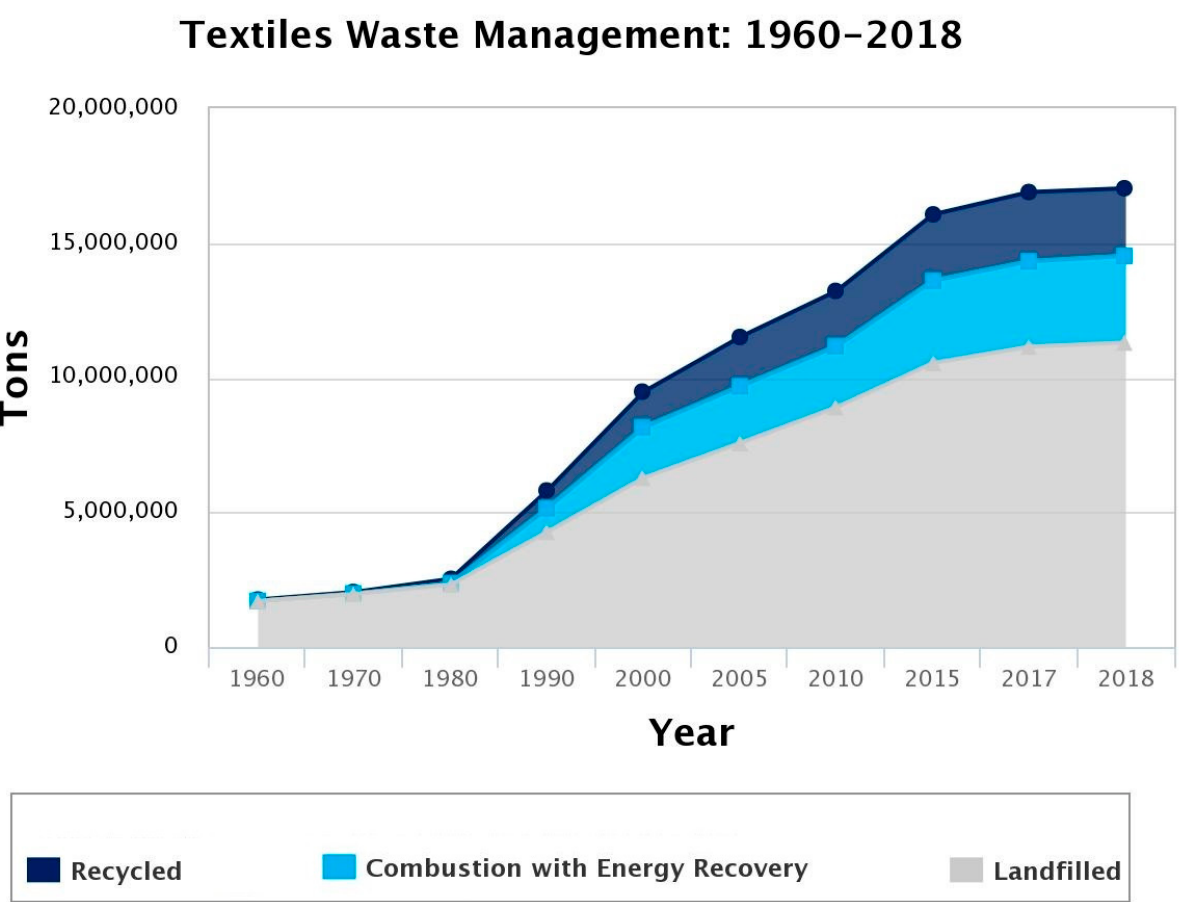
Figure 5. Trends of textile waste disposal for the period 1960–2018, reprinted with permission from Ref. [37].